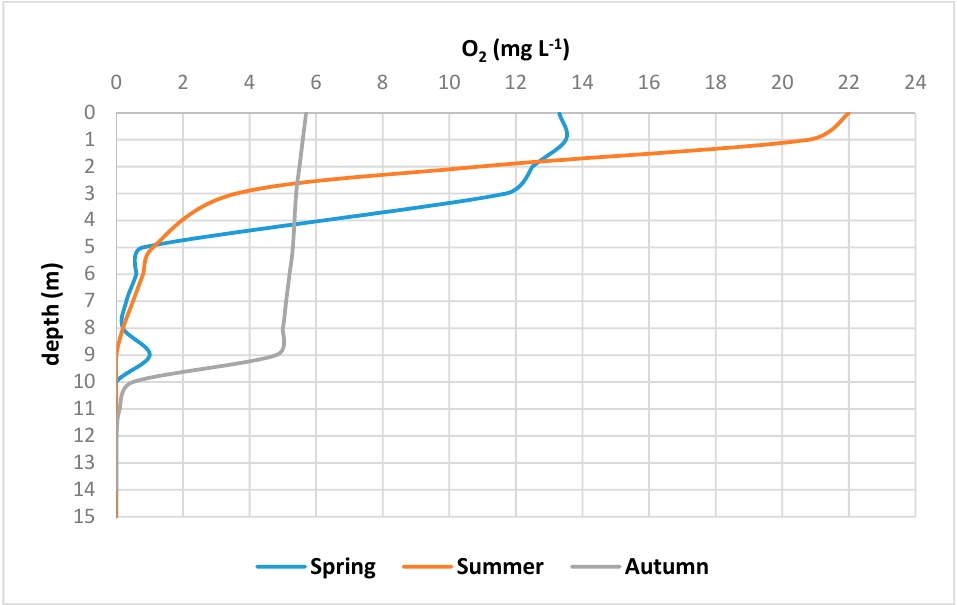
Figure 5. Annual (2018) oxygen settings in Miłkowskie Lake.